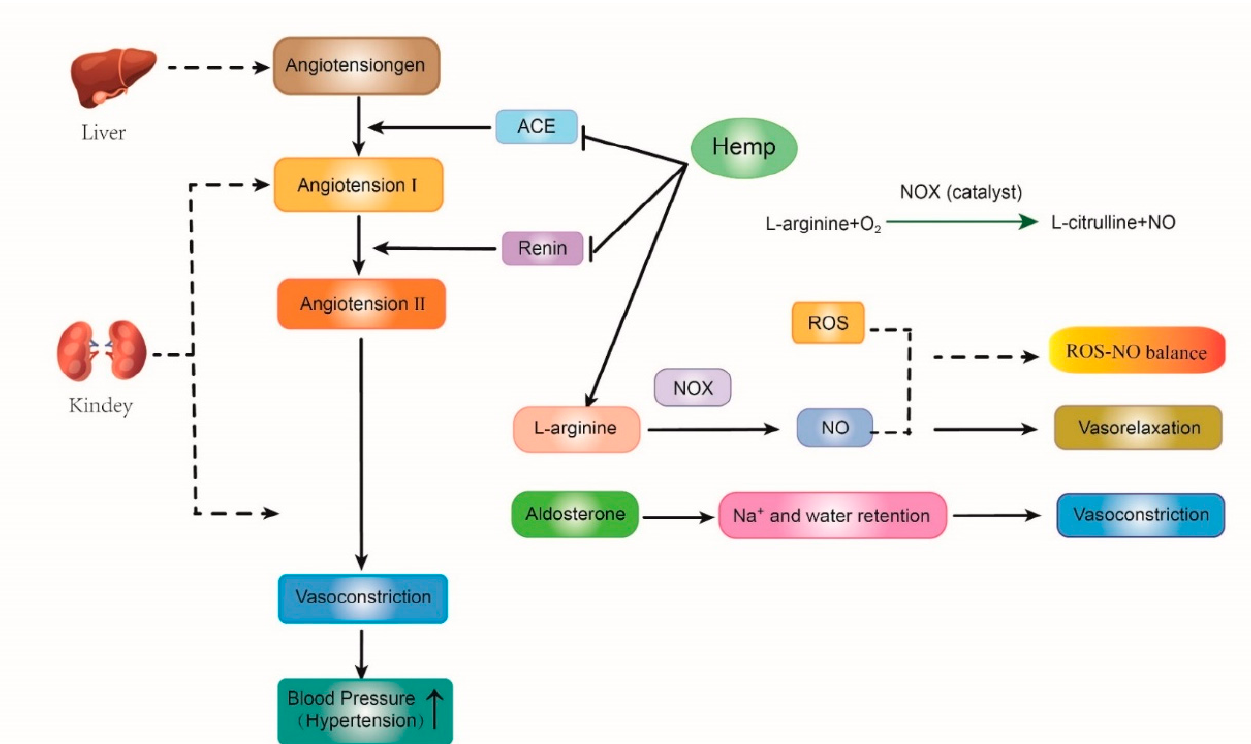
Figure 3. The mechanism of antioxidant and anti-inflammatory properties of hemp bioactive pep- tides on NF- κ B and Keap1-Nrf2 signaling pathway. ROS, reactive oxygen species; IKK β , inhibitor of κ B Kinase β ; NF- κ B, Nuclear Factor κ B; Keap1, Kelch-like ECH-associated protein 1; Nrf2, nuclear factor erythroid 2-related factor 2; ARE, antioxidant response elements; CAT, catalase; SOD, super- oxide dismutase; GPx, glutathione peroxidase; HO-1, Heme Oxygenase-1; P, phosphorylation; represents promote or active; represents inhibit or inactive.